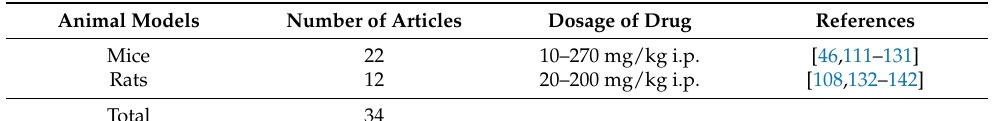
Table 2. Summary of data collected from in vivo animal studies involving irinotecan (CPT-11)- induced intestinal mucositis. Drug concentrations obtained from studies are listed in a range of minimum to maximum dosage administered in animal